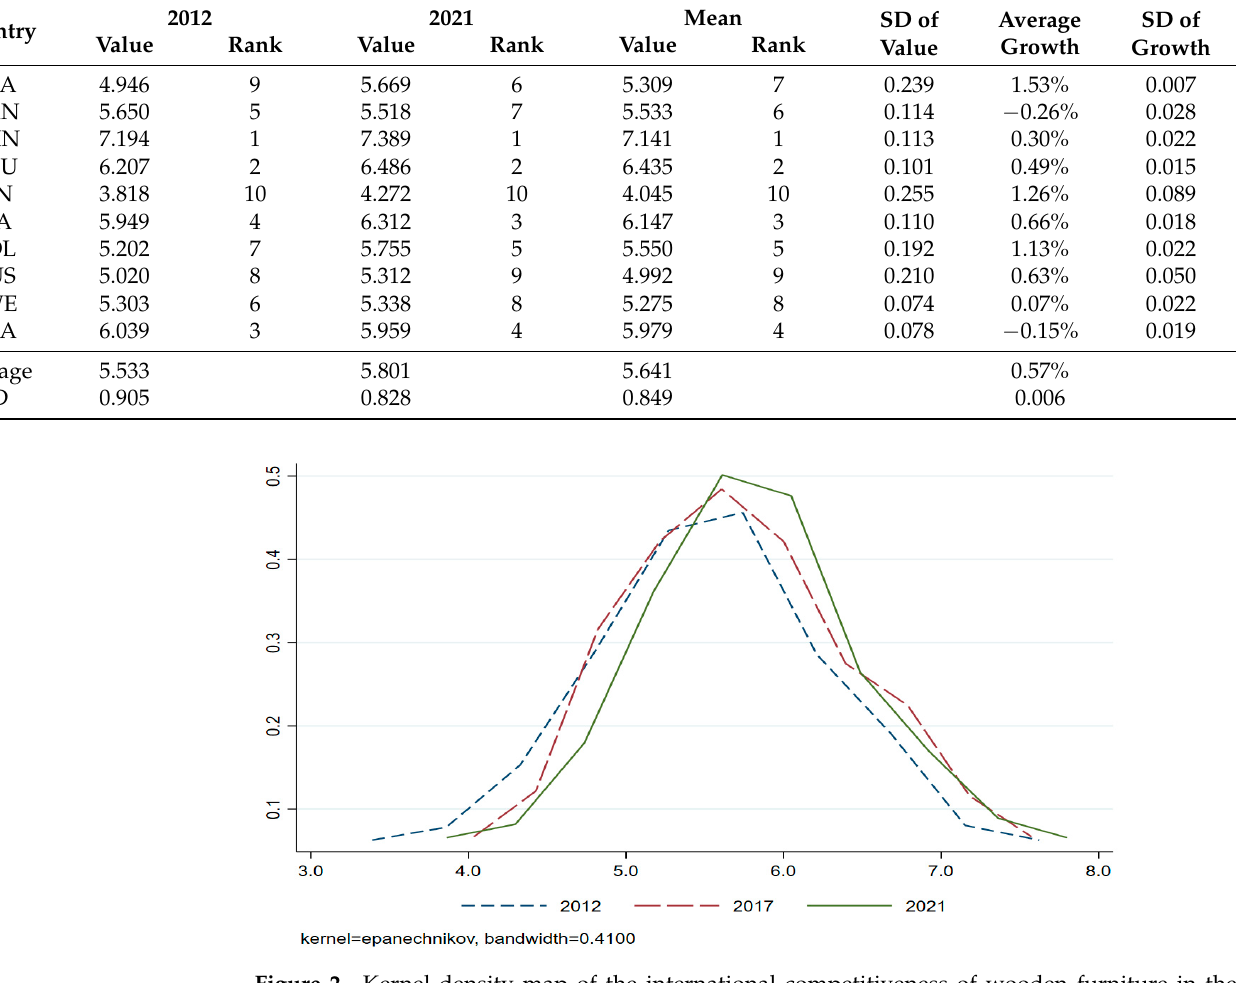
Figure 2. Kernel density map of the international competitiveness of wooden furniture in the countries observed.